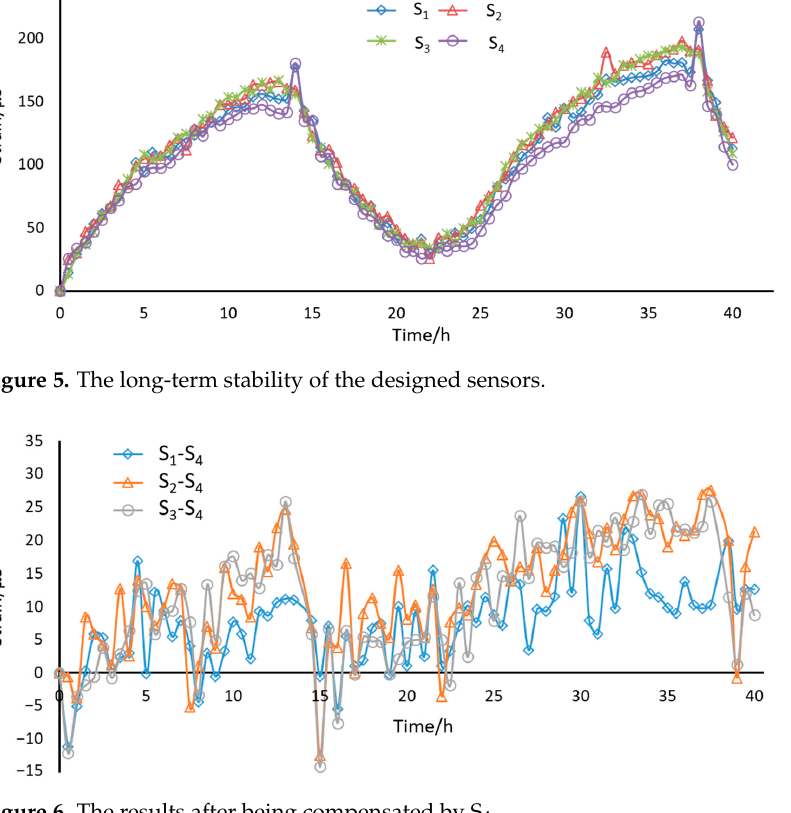
Figure 8. Fiber-optic sensors response of the bearing under the loading and unloading. 4. Discussion Figure 8 describes some aspects of the fiber-optic sensors’ response to the loading and unloading: the fiber-optic sensors and bearing deformations agree in behavior; the sensor S 1 gives the greatest response of 145.25 με under the load of 5000 kN, which seems to be the most suitable sensor for the bearing load measurement; the loading curves and unloading curves are inconsistent, and form hysteresis loops, which is not conductive to the loading calculation. The load-strain diagram of the sensor S 1 is shown in Figure 9. The polynomial fitting curves are calculated by the programs to predict the load applied to the bearings. Because of the non-coincidence between the loading curve and the unloading curve, the deviation